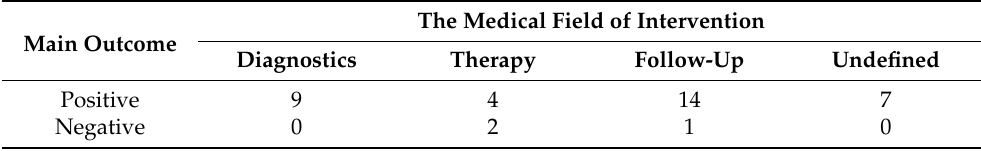
Table 1. The main outcomes of the different medical fields of intervention among the 37 records that compared tele-orthopedics and face-to-face orthopedics. The Medical Field of Intervention Main Outcome Diagnostics Therapy Follow-Up Undefined Positive 9 4 14 7 Negative 0 2 1